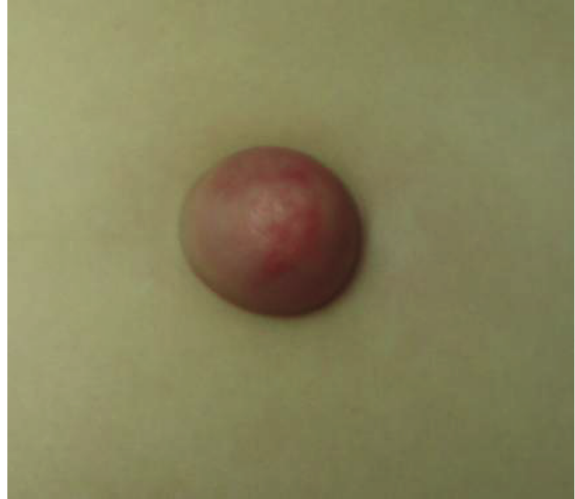
Figure 1: Clinical presentation of the incarcerated umbilical hernia (front view).